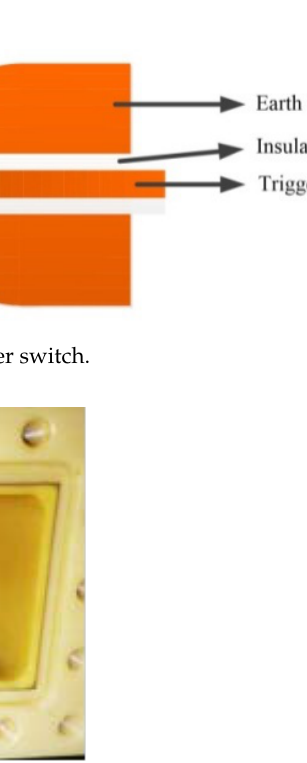
Figure 6. Photograph of the trigger switch.